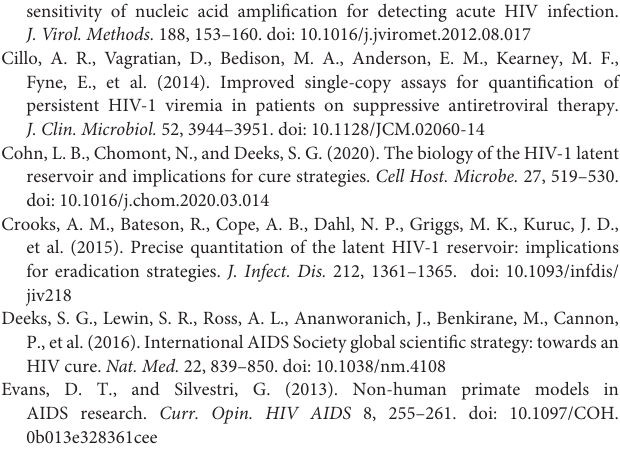
Supplementary Figure 1 | IP-Simoa assay comparing HIV-negative biopsies to buffer. Tissues from five HIV-negative donors with three replicates each donor were tested alongside buffer-only samples. After the procedure was complete, the buffer only samples were indistinguishable from the tissue samples indicating that there is no background contribution of the matrix to the